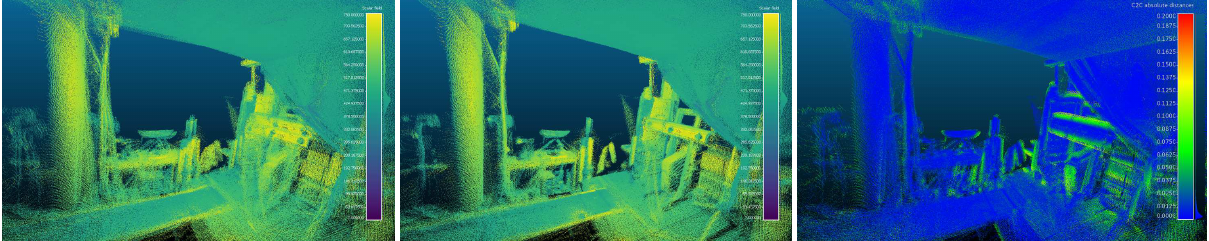
Figure 10. 3D point cloud of the laboratory. Left: Recorded data. Middle: Corrected point cloud used as reference. Right: Error between recorded and corrected point clouds.